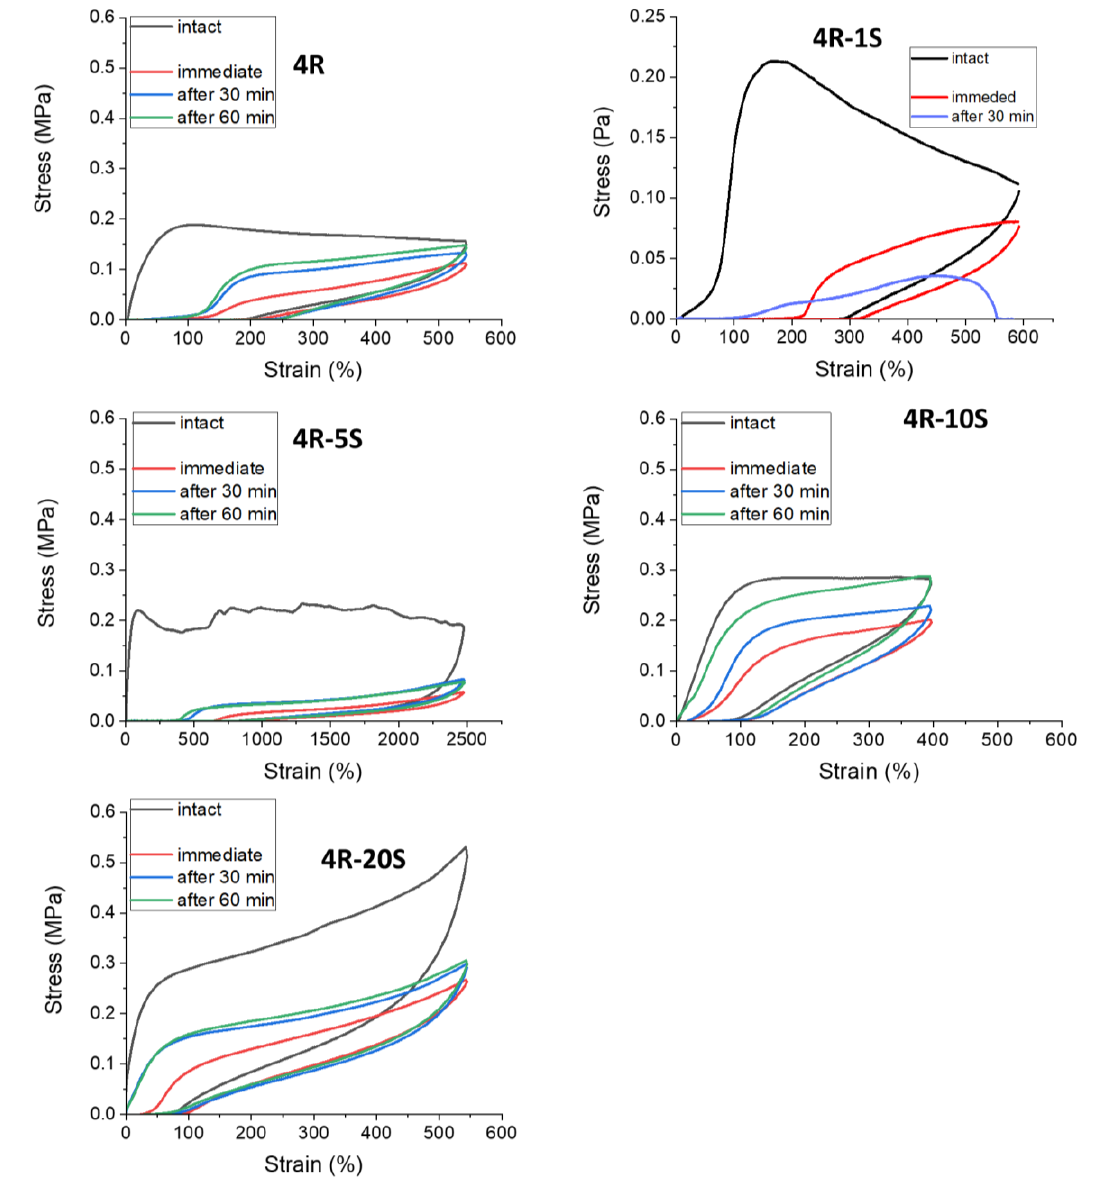
Figure 15. Effect of SMA co-monomer content on the Self-Recovery behavior of nanocomposites filled with 4 wt.% of clay: SMA contents were 0, 1, 5, 10, and 20 mol%.